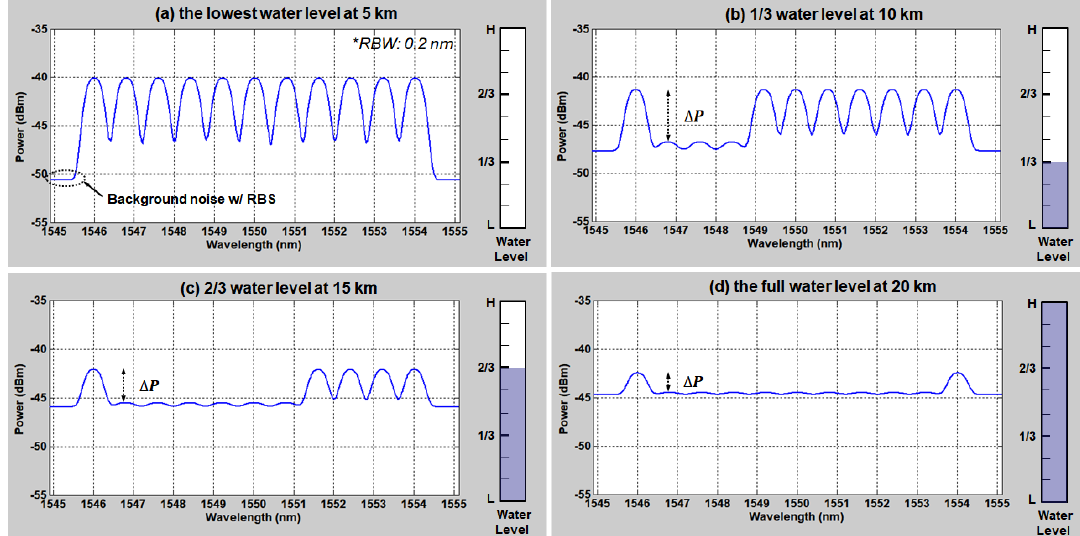
Figure 4. Simulated optical spectra according to the water levels at the different distances with RBS ( a ) the lowest water level at 5 km, ( b ) 1/3 water level at 10 km, ( c ) 2/3 water level at 15 km, and ( d ) the full water level at 20 km.